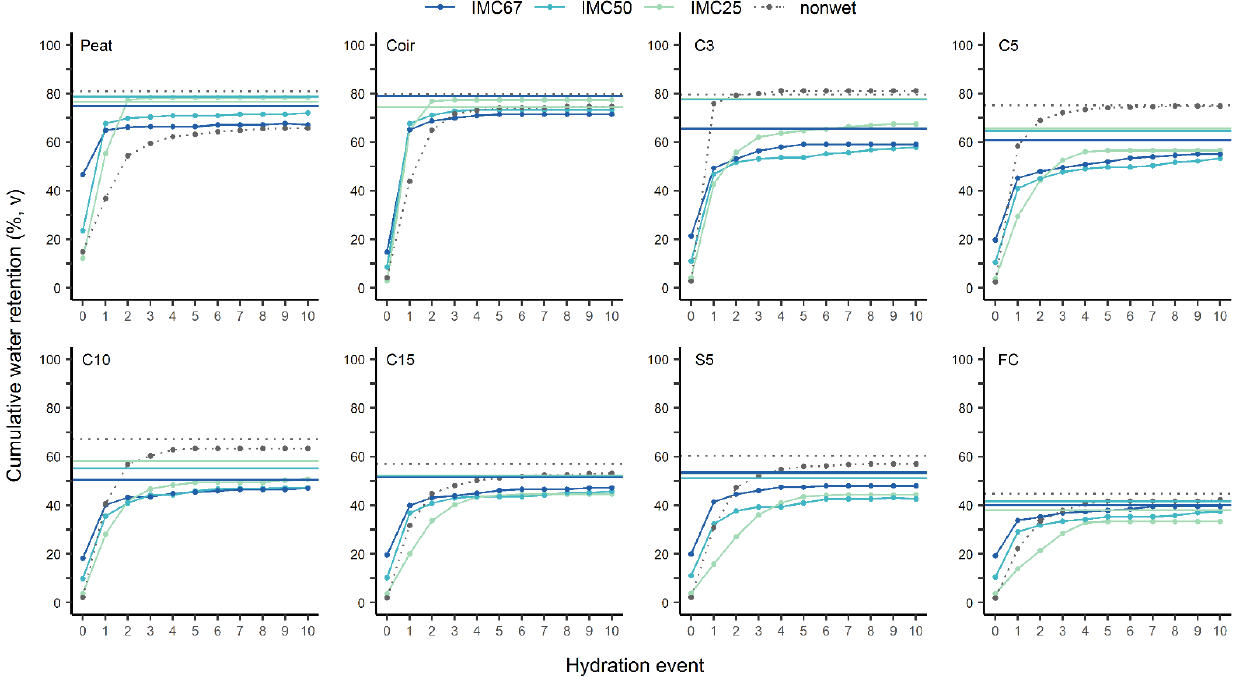
Figure 5. Hydration curves of peat, coir, and six processed miscanthus substrates at different initial moisture content (67% w, 50% w, 25% w, and non-wet). The curves are cumulative water retention (volume) after 10 successive hydration events. The reference lines are water holding capacity of the substrates. Each data point is a mean of 4 replicates. Miscanthus × giganteus was harvested with a forage harvester (FC, field-chips), then processed with a mechanical fraying facility through a 5-mm screen (S5, shreds) or a hammermill with screen sizes of 15, 10, 5, and 3 mm (C15, C10, C5, and C3, chips). Commercial peat substrate amended with 30% clay.